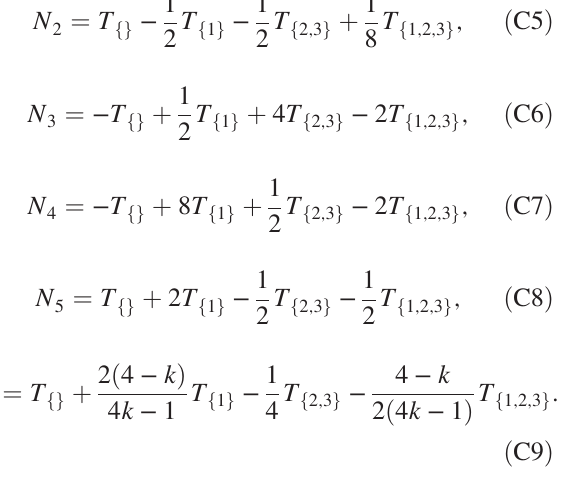
TABLE I. Edge coefficients λ α